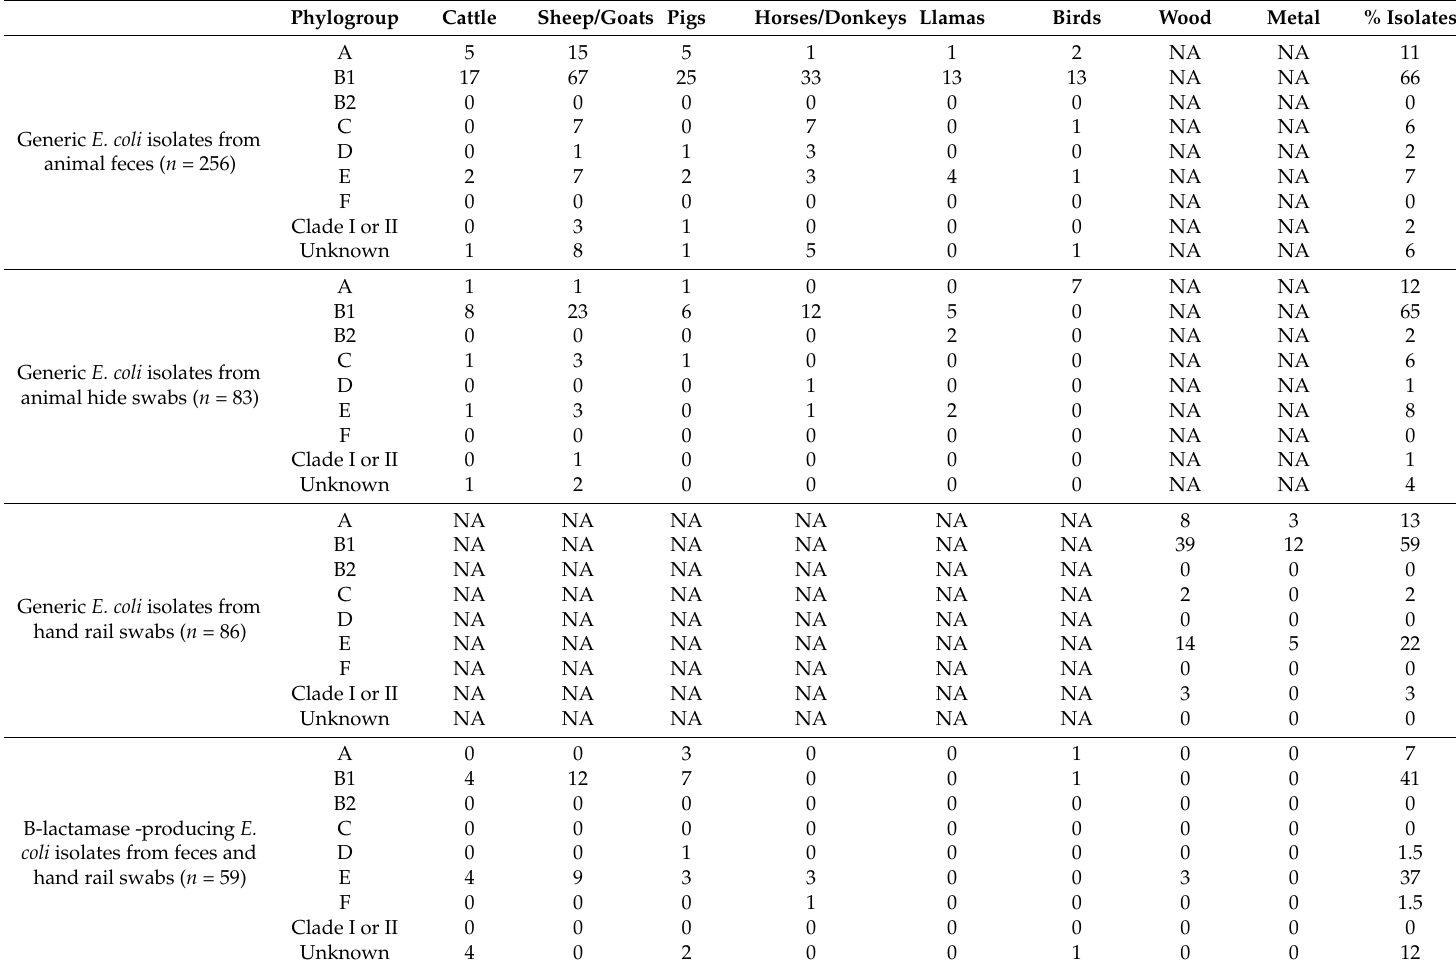
Table 6. Assigned phylogenetic groups (A, B1, B2, C, D, E, F, Clades I or II, or Unknown) of E. coli strains from different hosts based on multiplex PCR of 4 genetic markers ( arpA , chuA , yjaA , TspE4.C2). Numbers indicate the number of bacterial isolates obtained per species. An overall representation of bacterial isolates per phylogroup is given as a percentage out of the total number of isolates